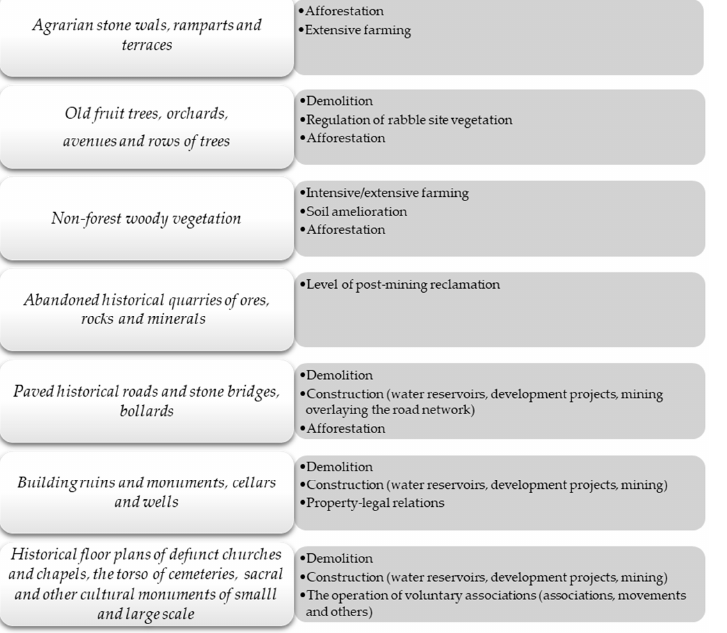
Figure 8. Causal structure of preserved historical landscape elements and anthropogenic